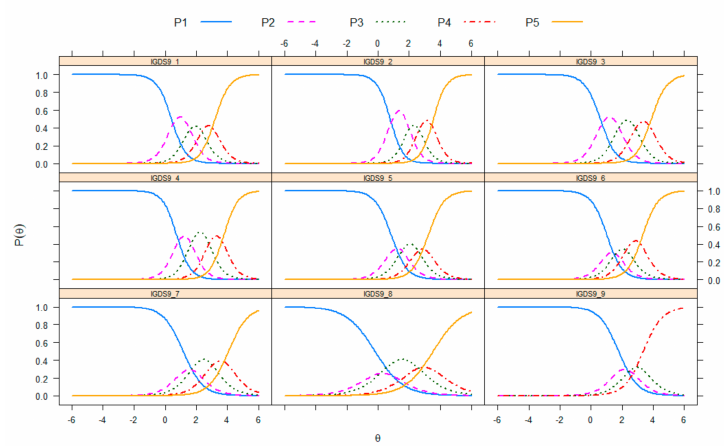
Figure 2. Category curves for the nine items of the Internet Gaming Disorder Scale-Short Form